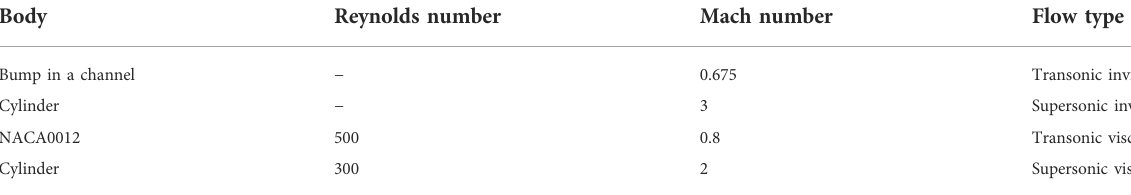
TABLE 1 Summary of test cases.